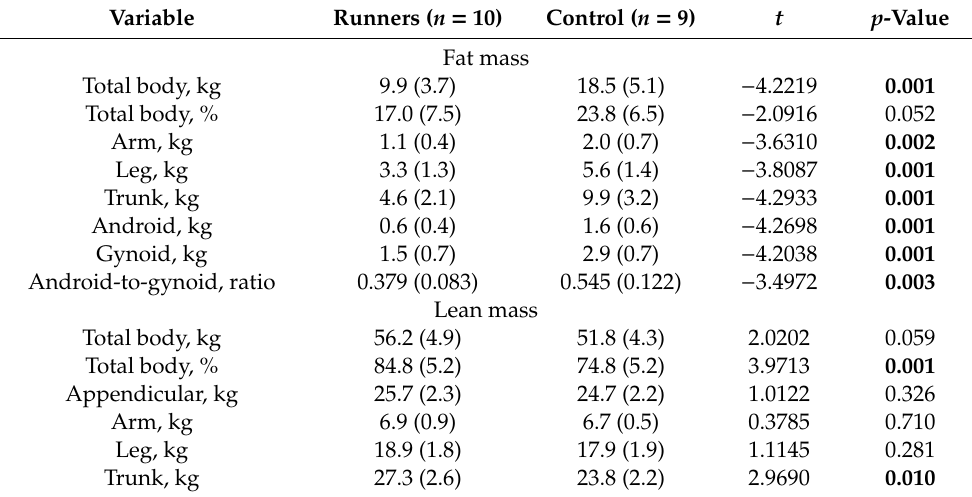
Table 2. Body composition (lean and fat mass) in runners ( n = 10) and controls ( n =